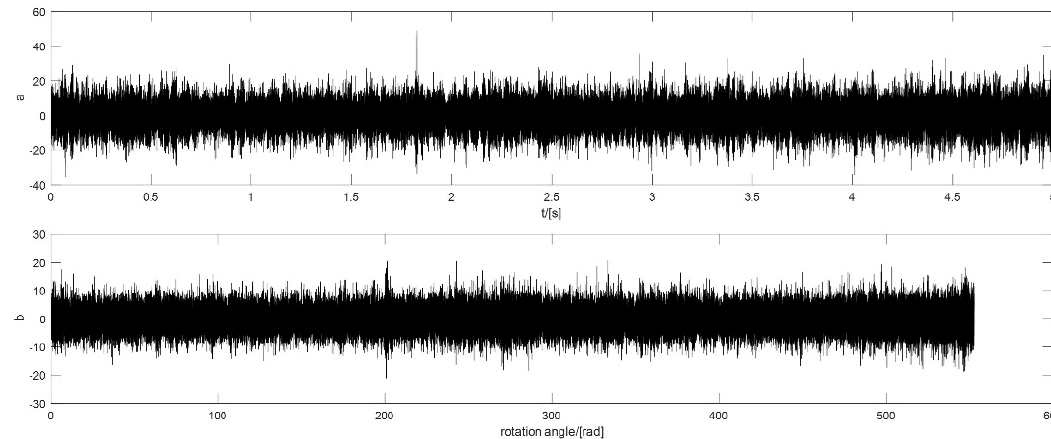
Figure 11. The vibration signal of outer ring defect with a slight acceleration of the speed: ( a ) the raw signal; ( b ) the signal after pre ‐ processing.